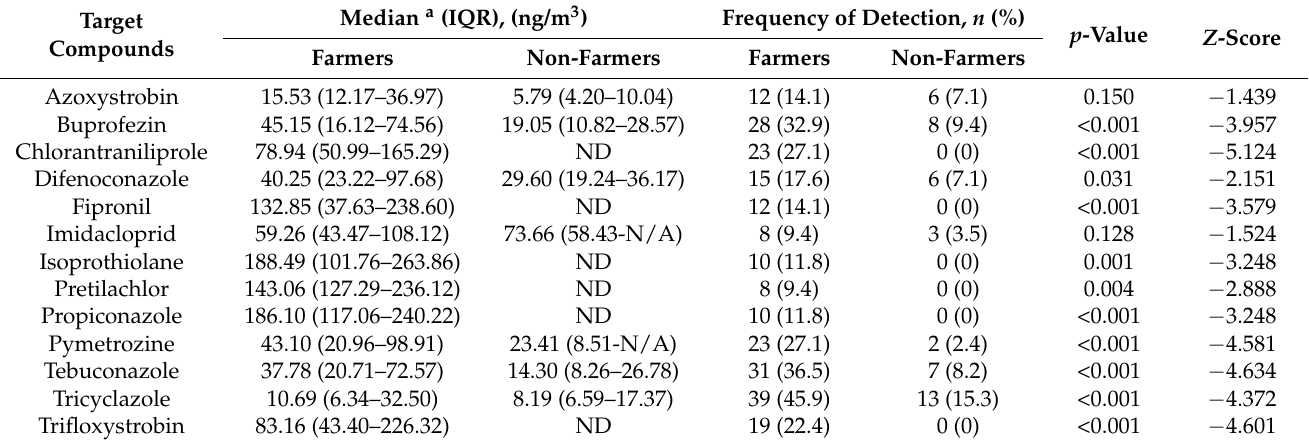
Table 4. Concentration of target compounds detected in personal air samples of farmers and non-farmers. Target